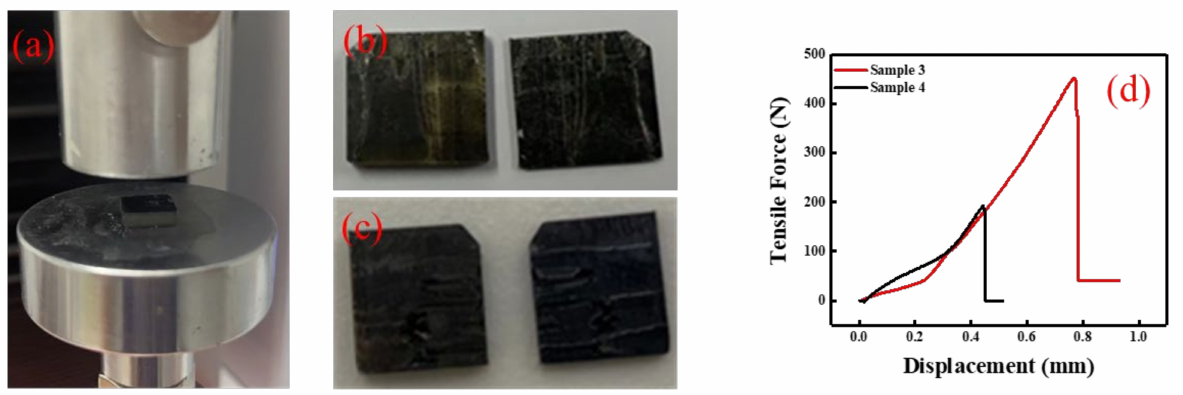
Figure 7. Tensile stripping experiment diagram. ( a ) The diagram of tensile test. ( b ) Sample 3 after the tensile test. ( c ) Sample 4 after the tensile test. ( d ) The relationship between surface preprocessing and tensile force.